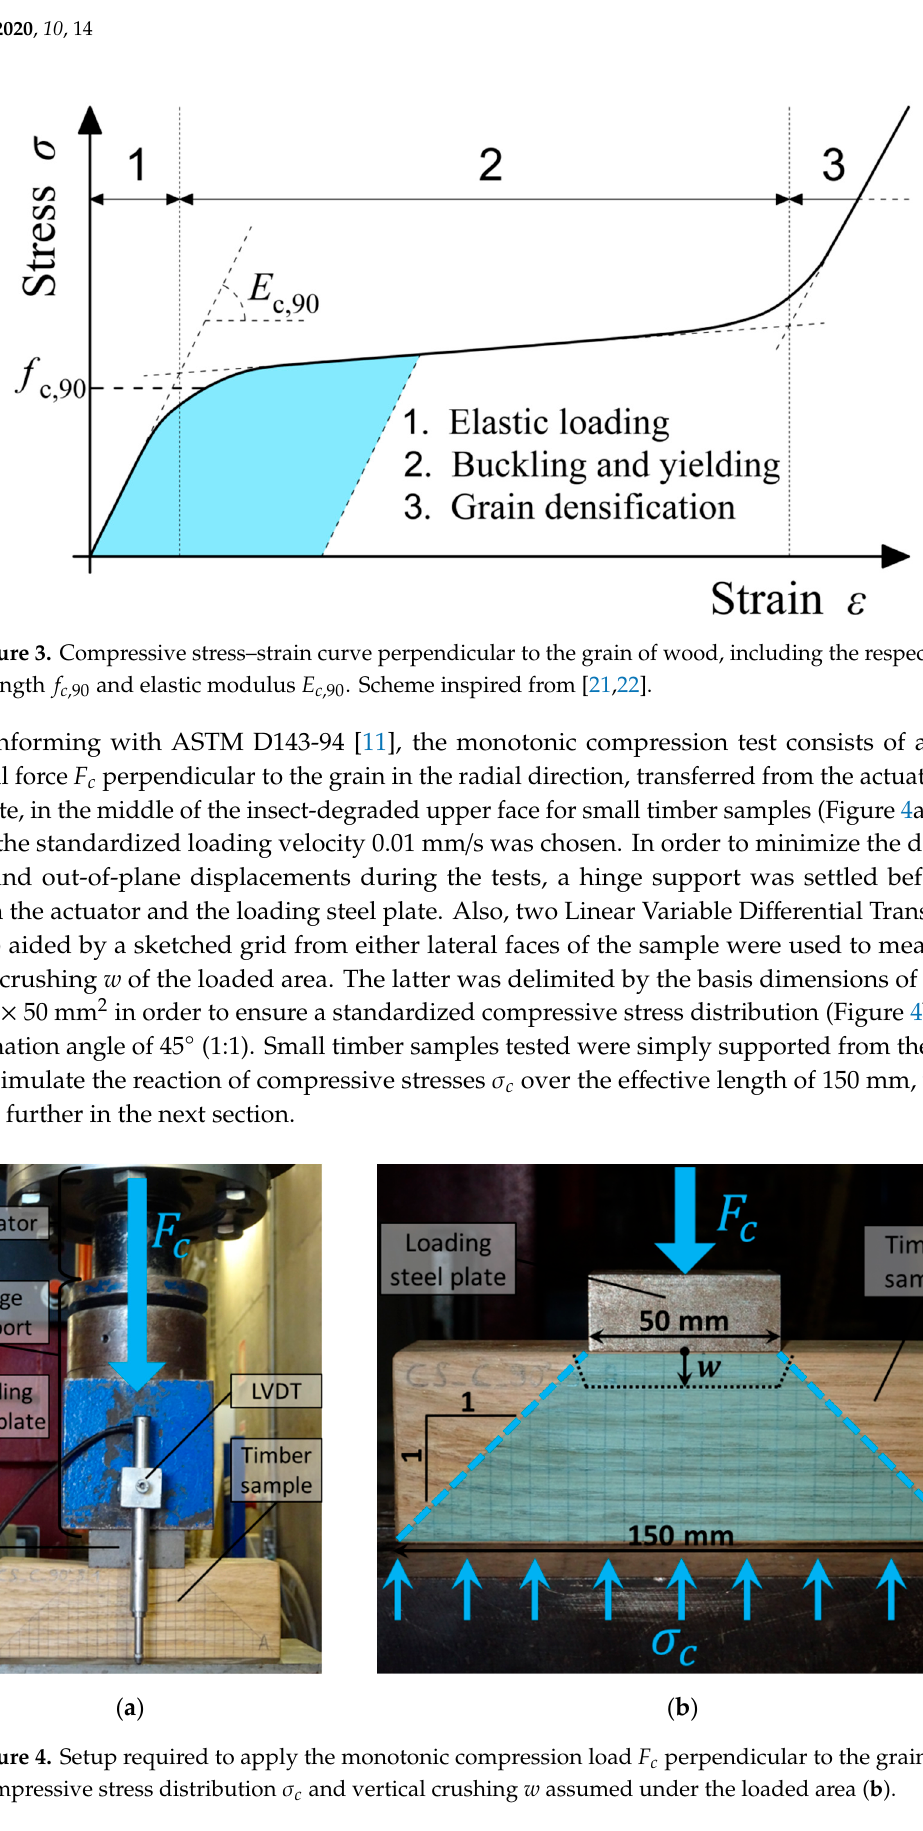
Figure 4. Setup required to apply the monotonic compression load F c perpendicular to the grain ( a ). Compressive stress distribution σ c and vertical crushing w assumed under the loaded area ( b